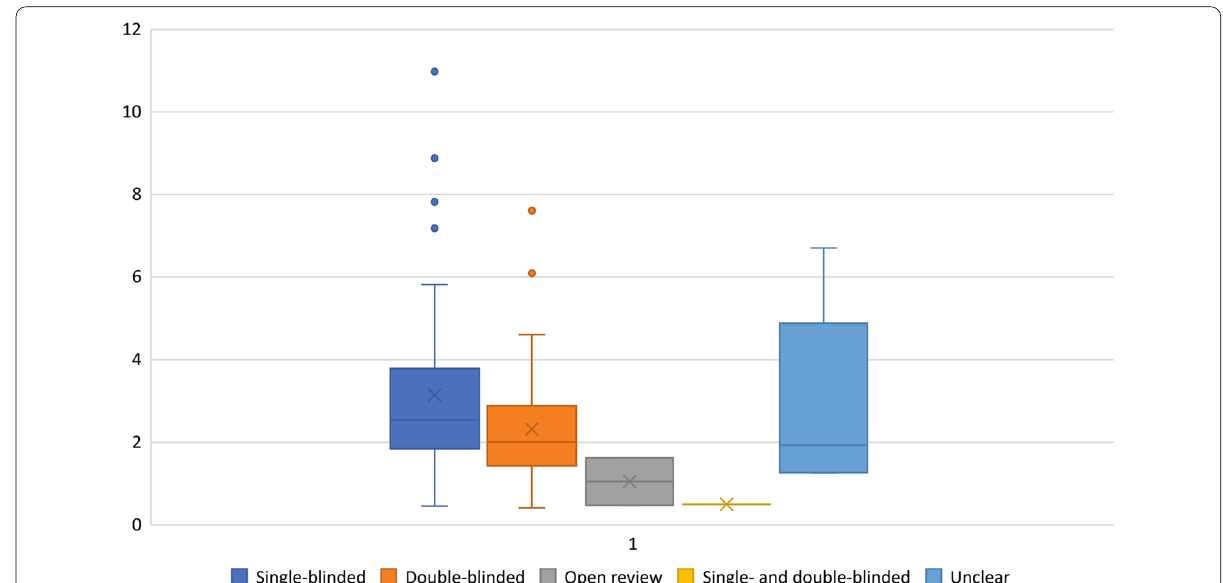
Fig. 2 Box-and-Whisker plot show median (cross), quartiles (top and bottom lines of box), upper extreme value (upper whisker), lower extreme value (lower whisker), and outliers (circles) for journal’s impact factor according to peer review